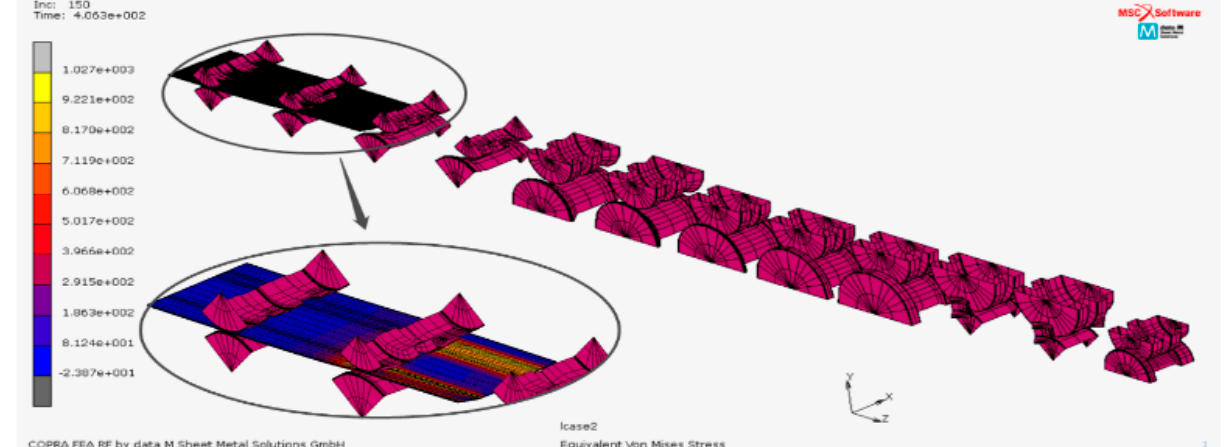
Figure 4. Automobile lower beam forming, roller flower drawing.